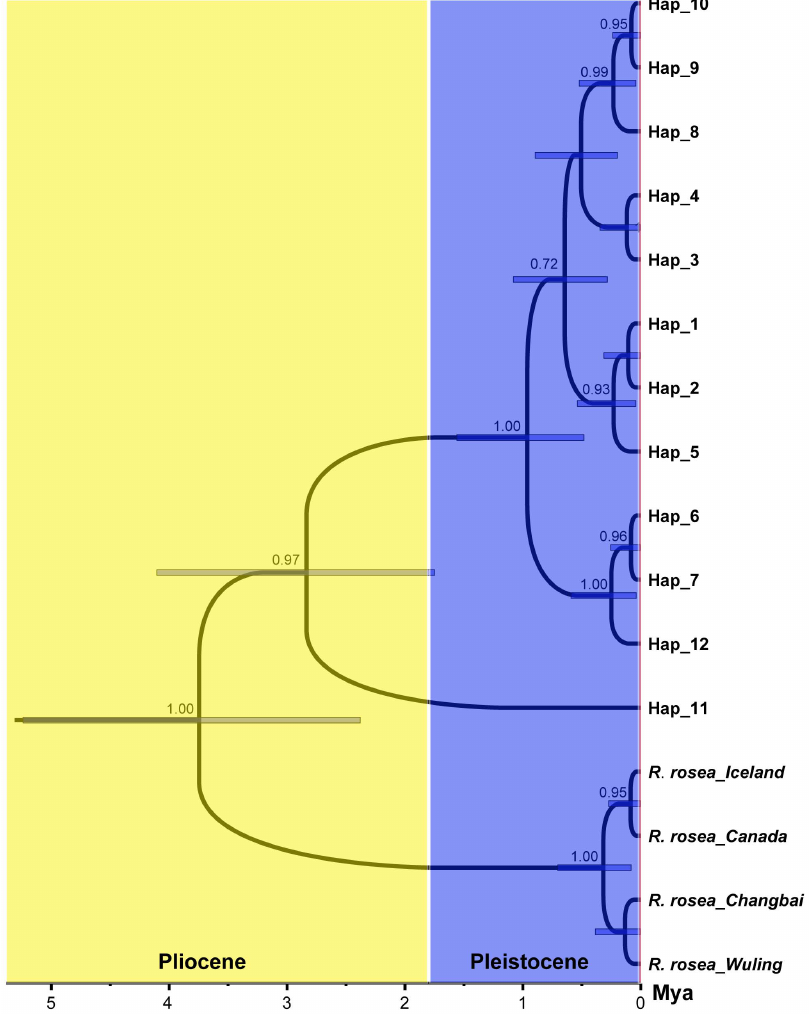
Figure 4. Maximum clade credibility tree of the ribotypes generated from BEAST. Gray bars indicate 95% highest posterior density intervals.